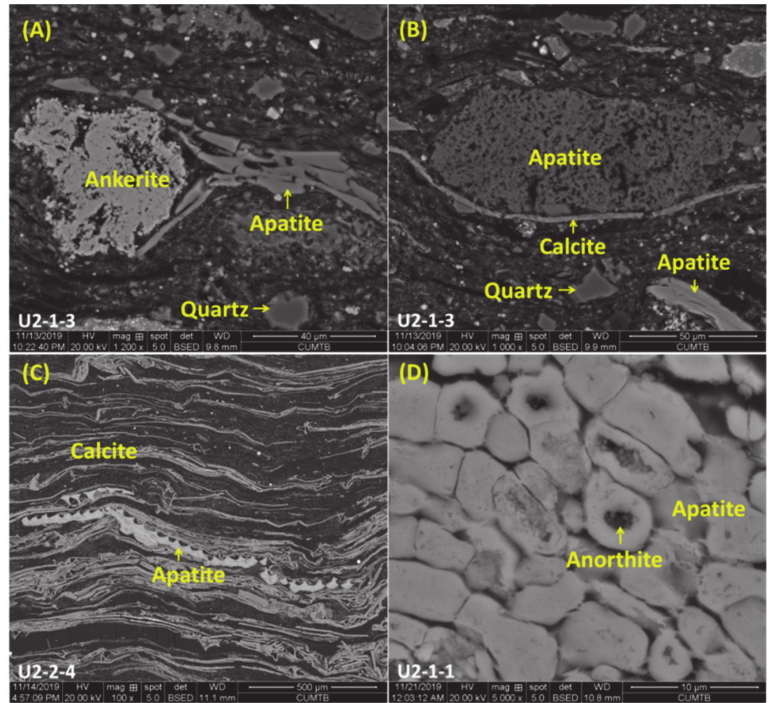
Figure 9. SEM backscattered electron images showing modes of occurrence of apatite in OS2 oil shales. ( A ) Rod-like apatite surrounds ankerite; ( B ) massive apatite surrounded by calcite laminae; ( C ) apatite replacing cell wall along calcite laminae; ( D ) dense apatite grains with anorthite